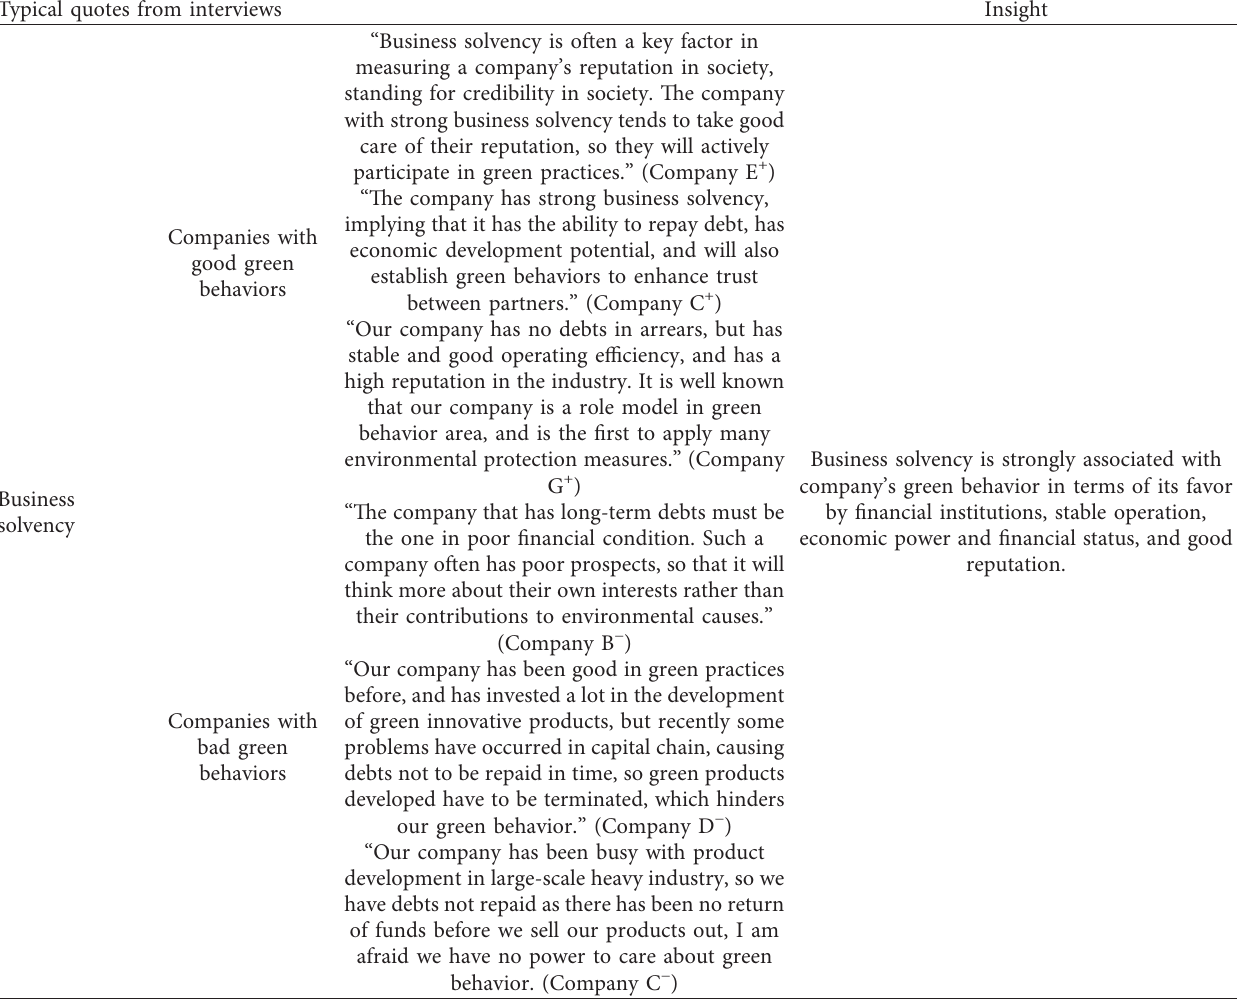
Table 8: Evidence from data illustrating major relationships between financial indicators and company’s green behavior. Typical quotes from